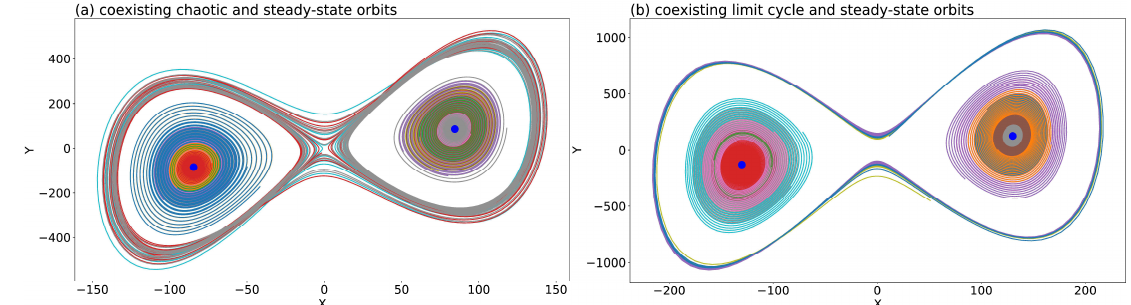
Figure 4. Two kinds of attractor coexistence using the GLM with 9 modes. Each panel displays orbits from 128 runs with different ICs for τ ∈ [0.625, 5]. Curves in different colors indicate orbits with different initial conditions. ( a ) displays the coexistence of chaotic and steady-state solutions with r = 680. Stable critical points are shown with large blue dots. ( b ) displays the coexistence of the limit cycle and steady-state solutions with r =